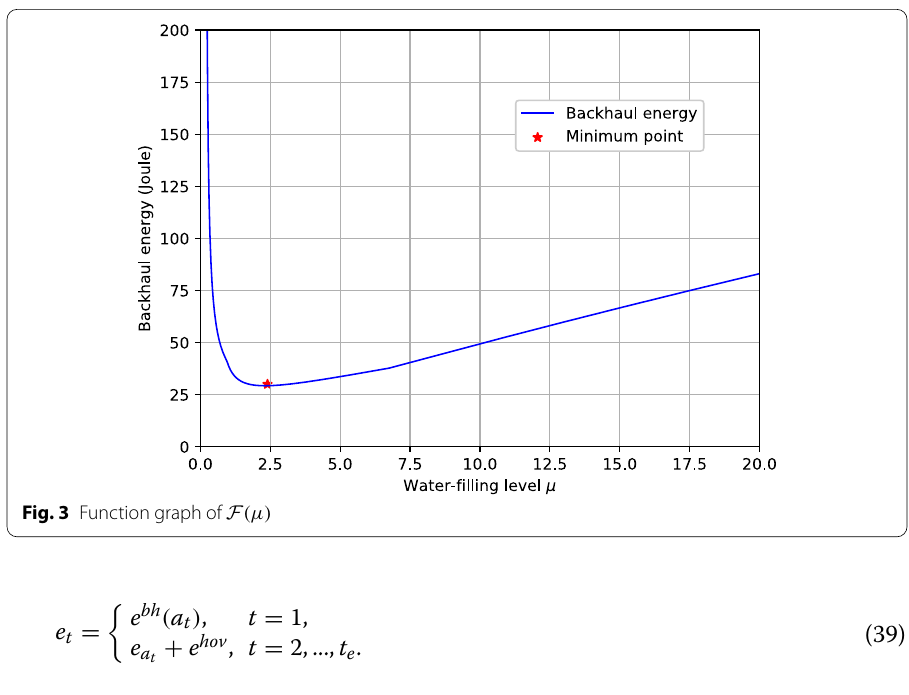
Fig. 3 Function graph of F